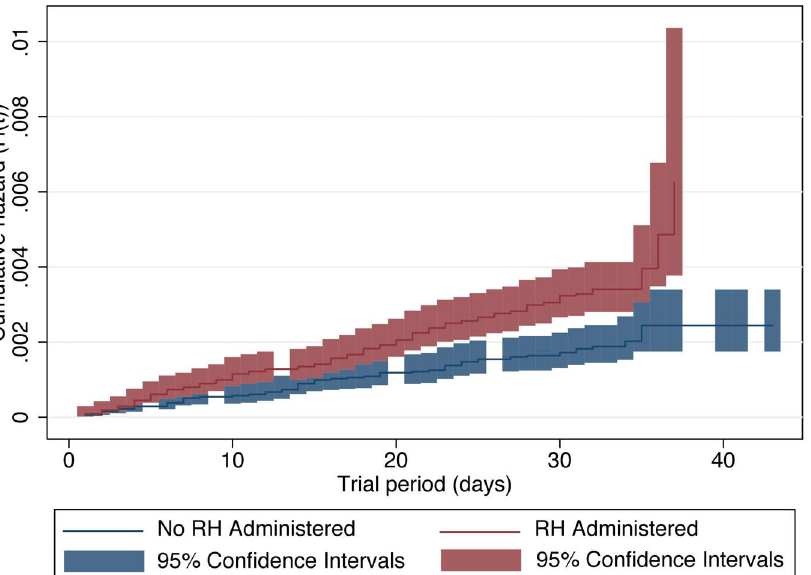
Figure 3. Force of mortality among cattle administered a b -adrenergic agonist. Empirical cumulative hazard function (H(t)) and 95% confidence intervals (during those time periods where mortalities occurred) for cattle administered a diet containing ractopamine hydrochloride (RH) compared to a diet without RH in Company C.